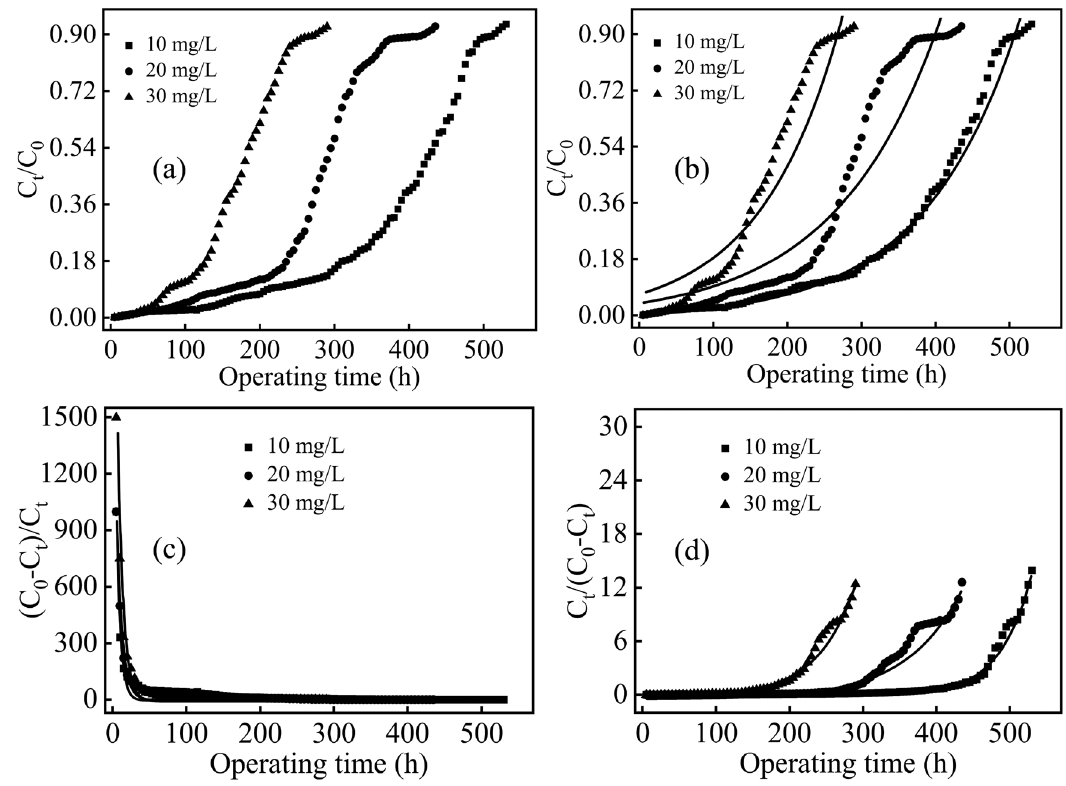
Figure 6: In fl uence of the initial concentration on the breakthrough curves of the treatment of MG dye from aqueous solutions by ceramsite - supported nZVI in a fi xed - bed reactor ( a ) , and the fi tting results of Thomas ( b ) , Y – N ( c ) , and A – B ( d ) fi xed - bed reaction kinetic models.